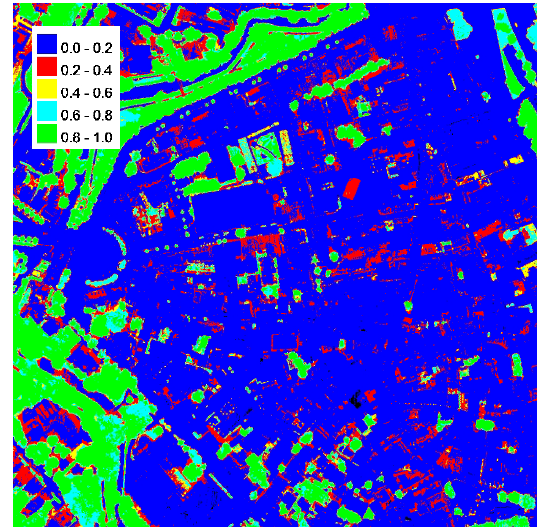
Figure 4: Calculated NDVI from the wavelengths of 673 nm and 849 nm, 500 m x 500 m subset.